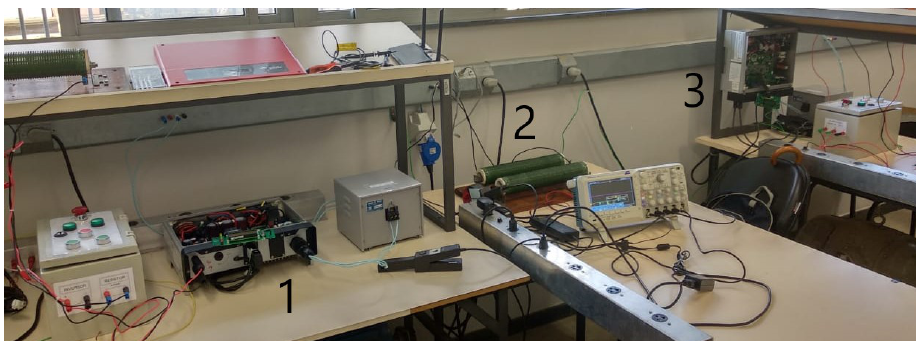
Figure 13. Picture of the inverter assembly for testing the VOC algorithm: (1) Inverter nº. 1, (2) Set of resistive loads, and (3) Inverter nº.